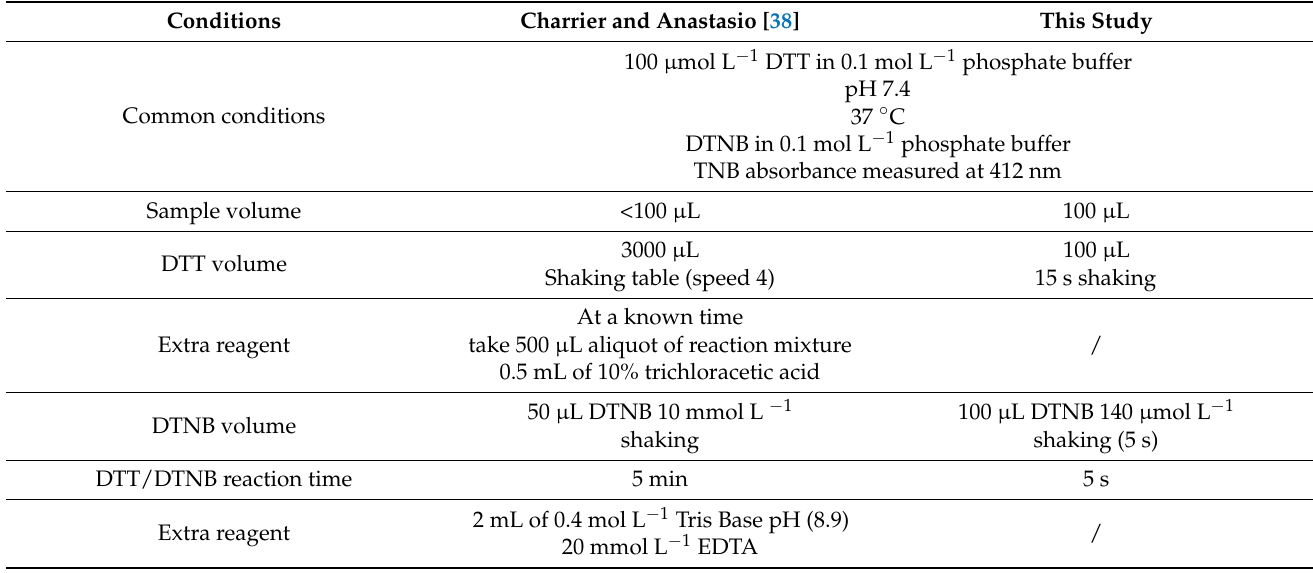
Table A7. Comparison of the OP DTT method used in this study and in Charrier and Anastasio [38].